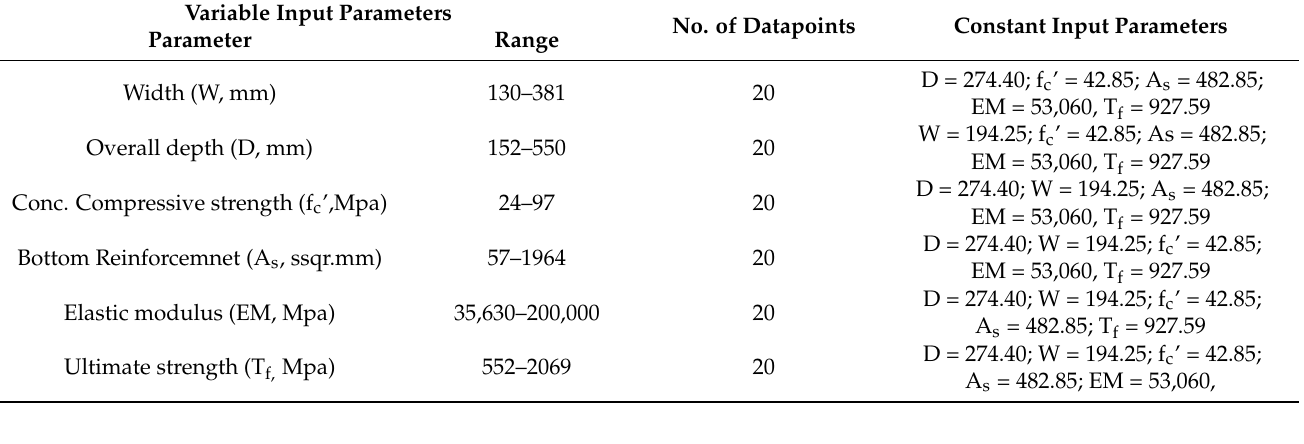
Table 4. Simulated data set used for Parametric and Sensitivity Analysis.